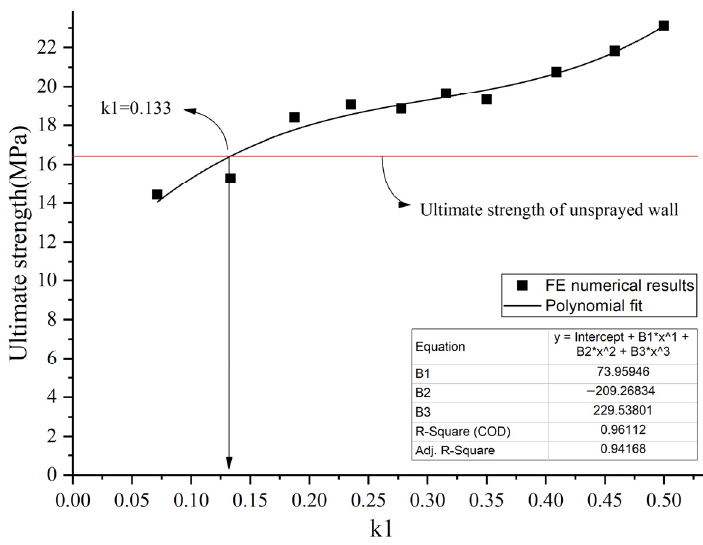
Figure 15. ( a ) Stress-strain curves of the simulation results in the elastic phase, and their; ( b ) Dif- ferential curves